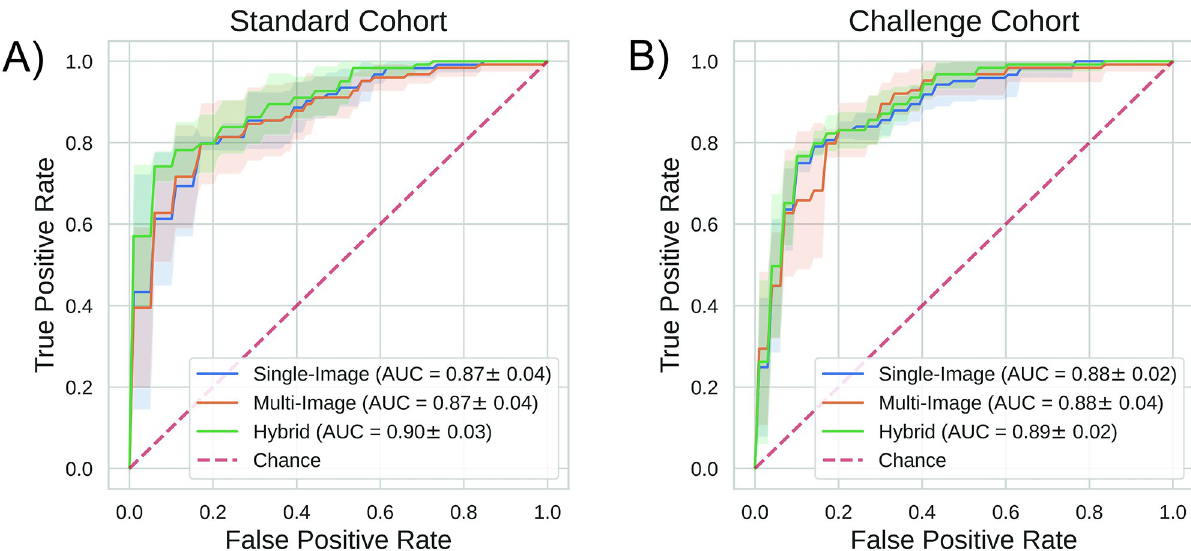
Fig 3. Performance of COVID-19 diagnosis from blood cell morphology analysis as measured by the receiver operator characteristic (ROC). Classification accuracy was 79% and 82% for the standard and challenge cohorts respectively. A) Results reported are the average across the entire dataset, k-fold cross validation was used to maintain independence between the training and test sets. B) COVID-19 positive patients were randomly selected from the standard cohort to counterbalance the COVID-19 negative patients from the challenge cohort (ROC-AUC calculation requires both positive and negative